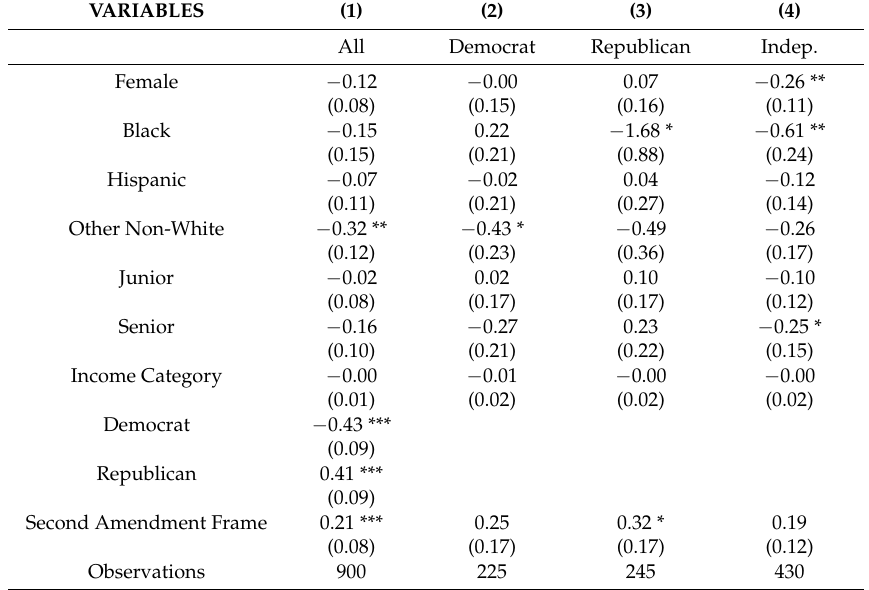
Table 6. Framing effects and attitudes towards gun ownership rights. Ordered probits: dependent variable is degree of agreement with the statement “the Second Amendment of the U.S. Constitution protects the right of the people to keep and bear arms. I believe that it is important for Americans to be able to practice this right” (Second Amendment frame) or “it is important for Americans to have the right to arm themselves with guns” (no frame).